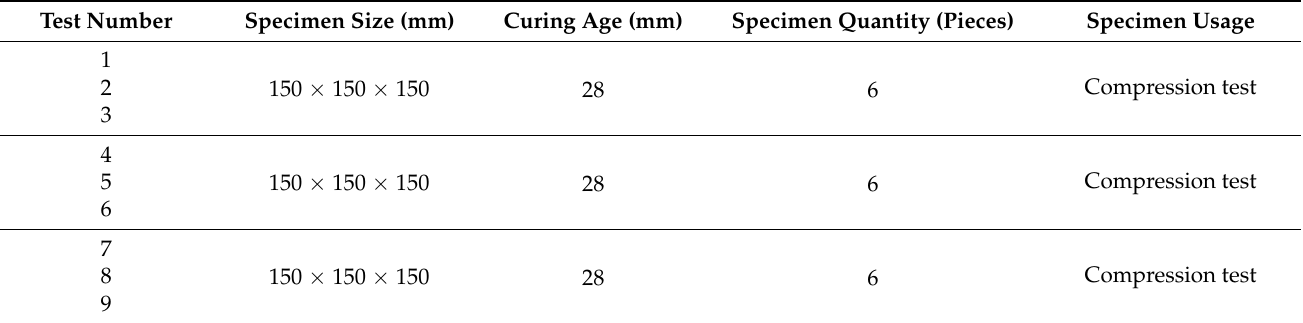
Table 2. Compression test program table.